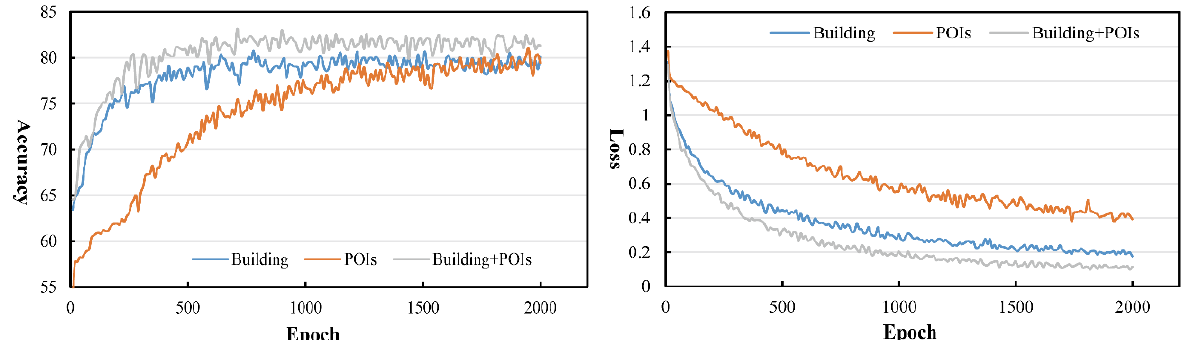
Figure 8. The accuracy and loss with respect to epoch of different datasets.